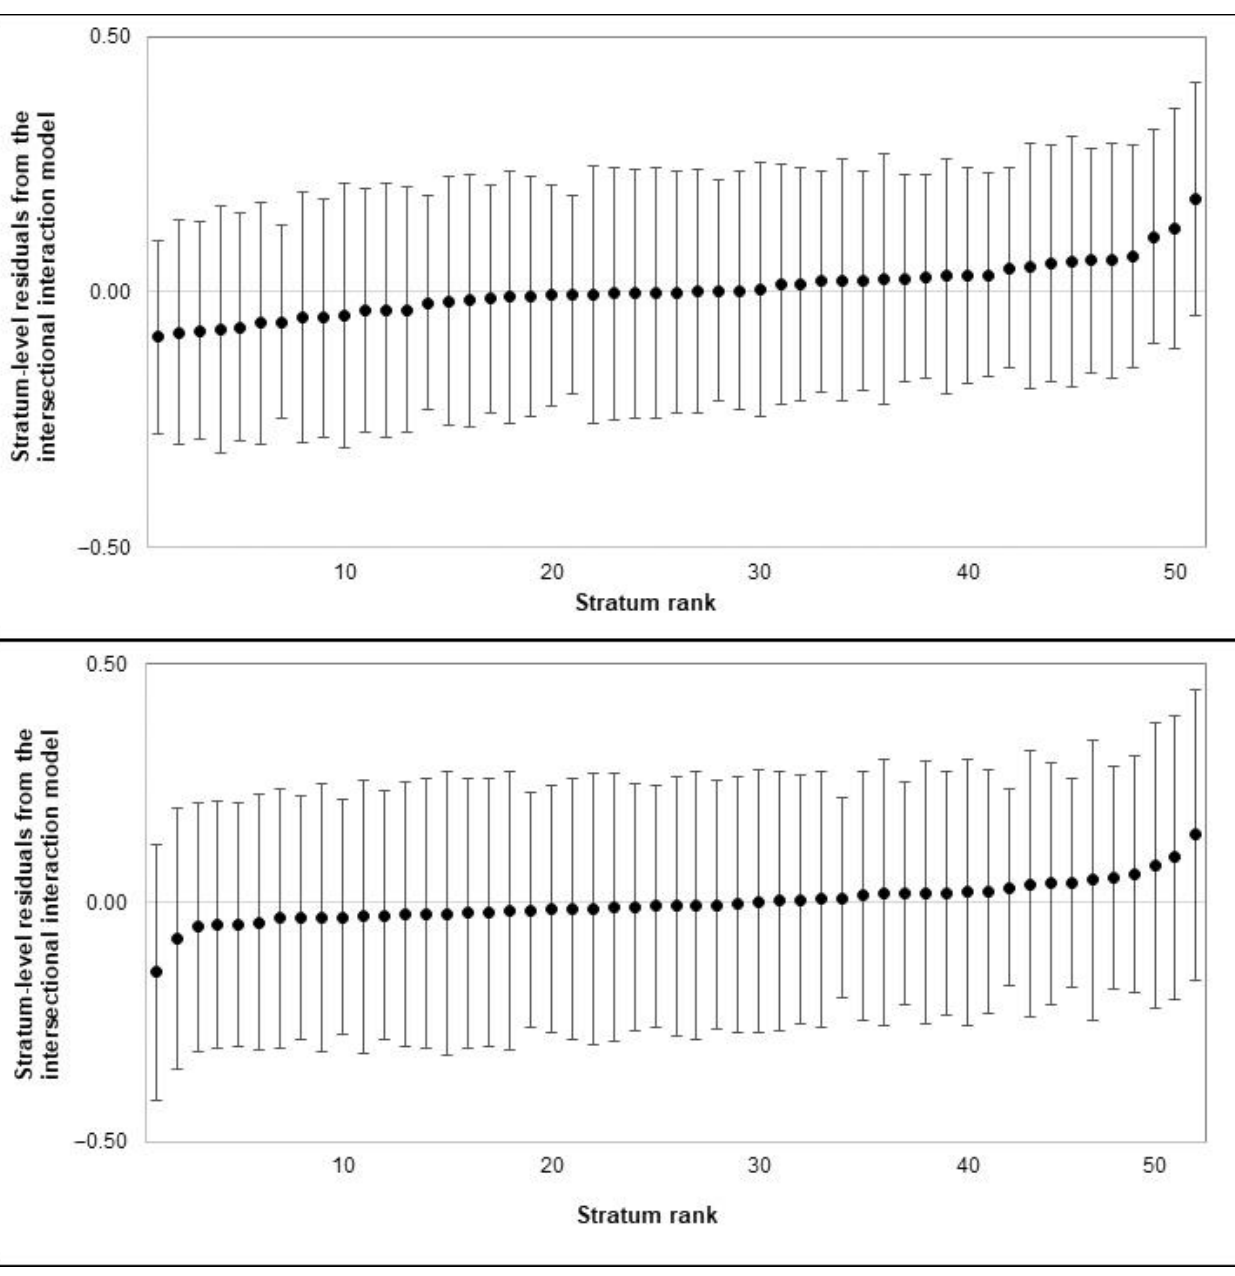
Figure 2. Intersectional interaction effects of ethnicity, nativity status and education on the numbers of teeth with PD (top plot) and CAL (bottom plot). Stratum residuals are the remaining difference between total predicted values for each stratum and stratum-level predictions based on additive effects only. Markers indicate estimated effects, and whiskers indicate 95% credible intervals. Intersectional strata were ordered according to their interaction effect. Negative and positive values indicate the number of teeth affected was below and above predicted scores for a given stratum, respectively.